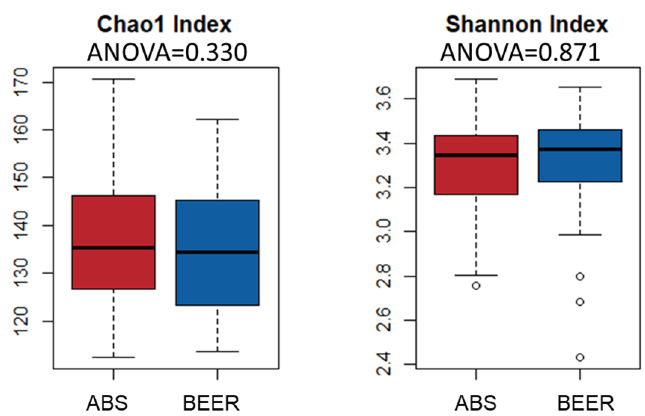
Figure 1. Differences in α diversity indices (Chao1 and Shannon) between beer consumption groups. ANOVA test.